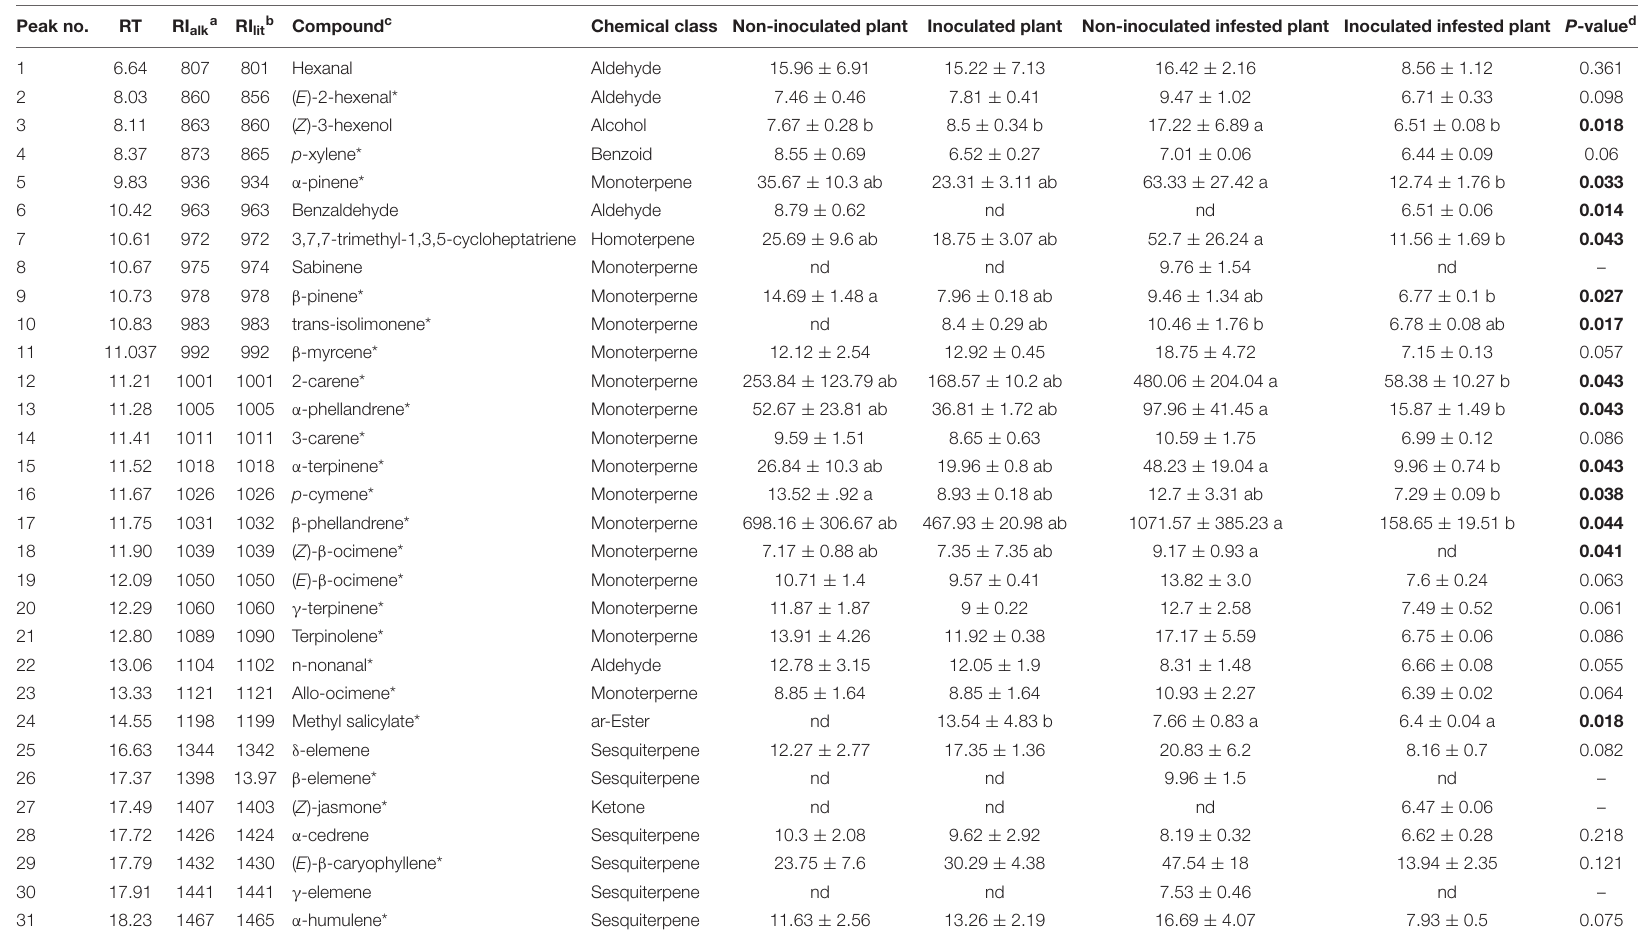
TABLE 3 | Mean amount (ng/plant/h) of volatile compounds identified in the headspace of non-inoculated, inoculated, non-inoculated infested, and inoculated infested tomato plants ( n = 3). Peak